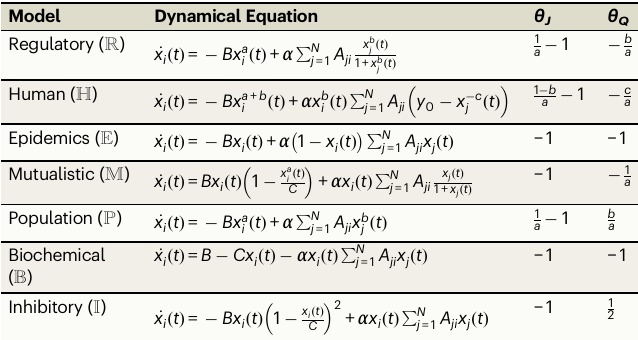
Table 1 | Scaling exponents θ J and θ Q for prototypical dynamical models